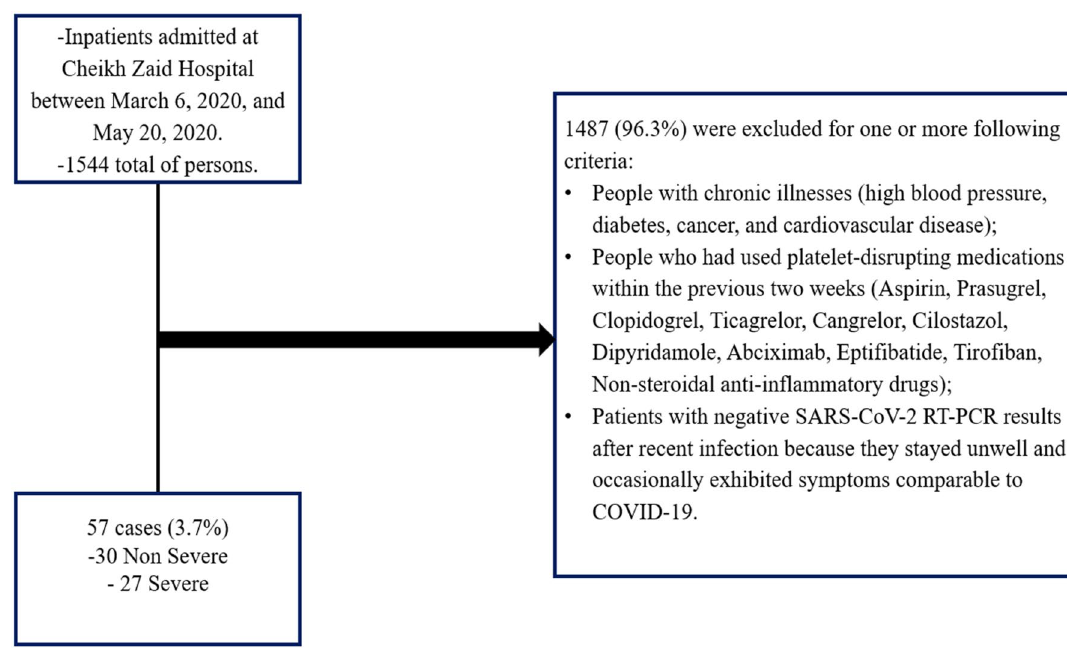
Figure 2. Flowchart of cases